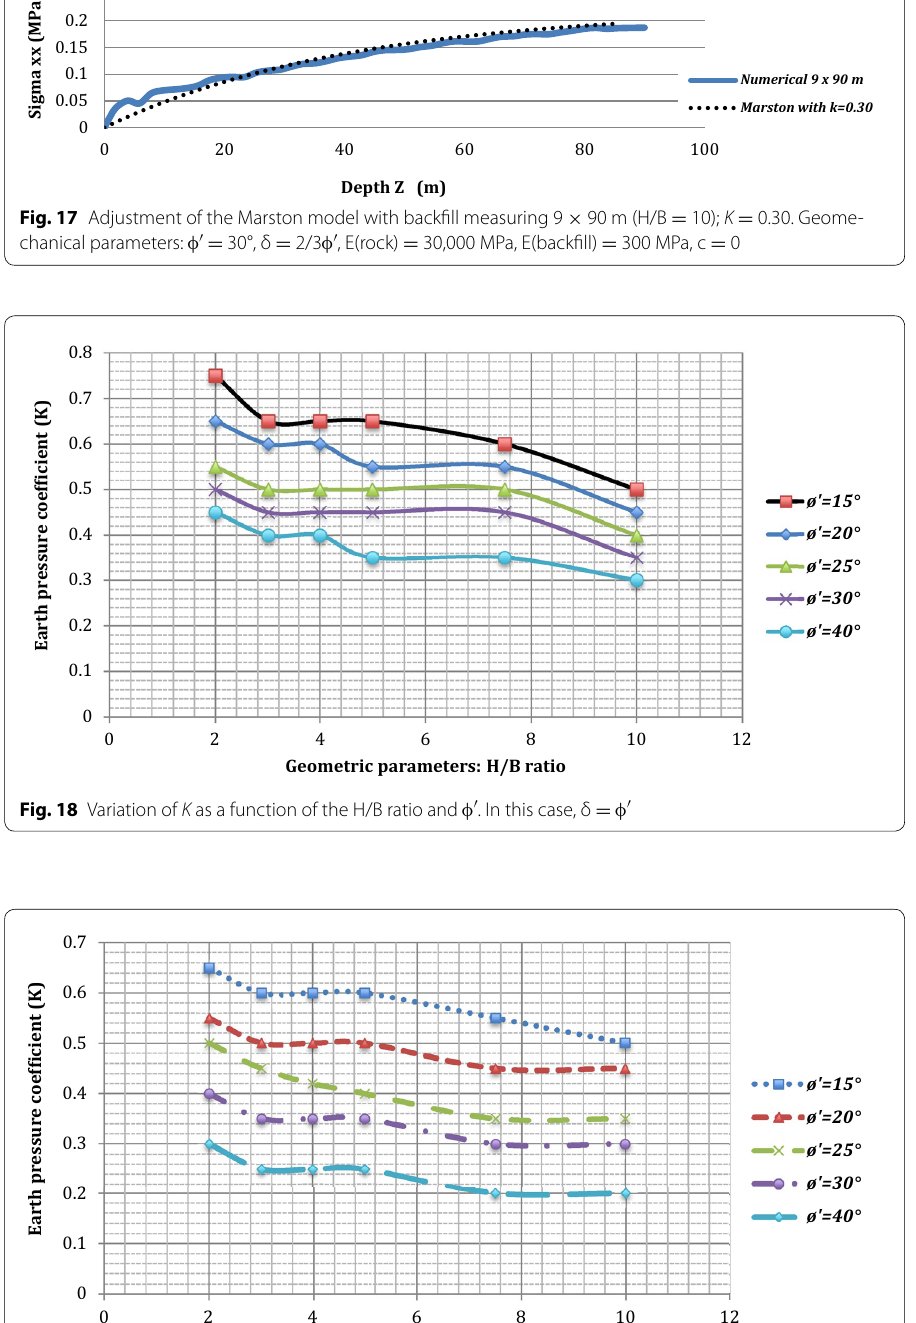
Fig. 19 Variation of K as a function of the H/B ratio and φ ′ . In this case, δ